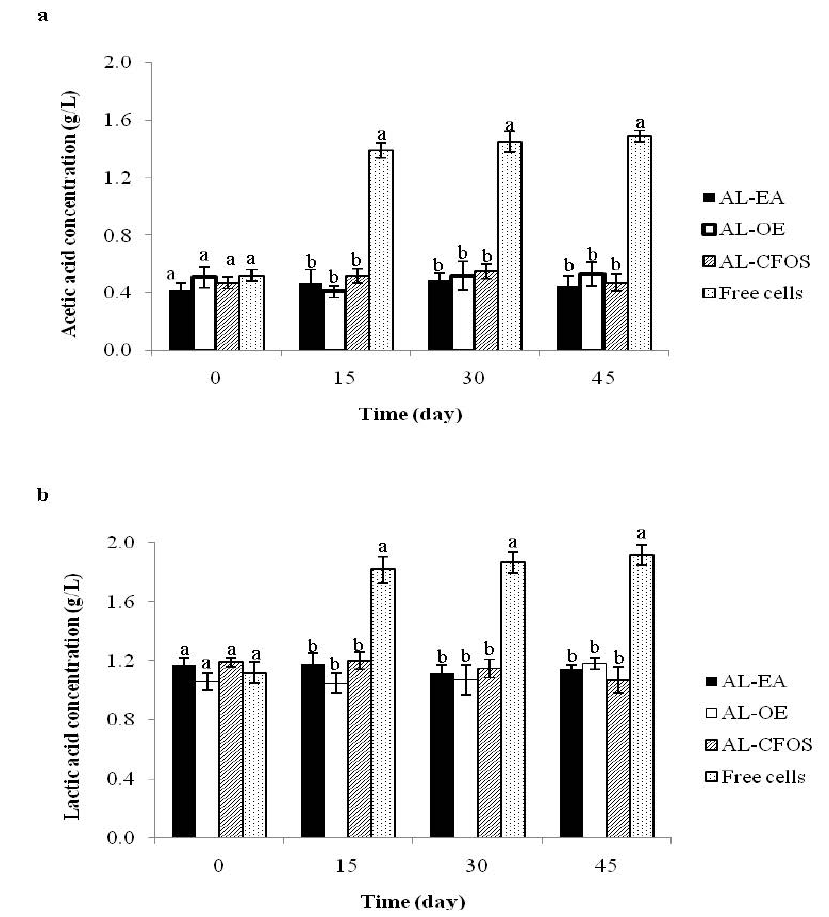
containing free cells during refrigeration storage.